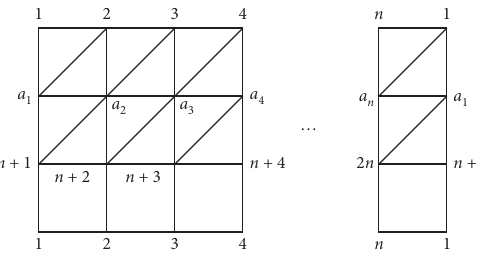
Figure 10: DSEM of type- [ 3 6 : 3 3 , 4 2 ]